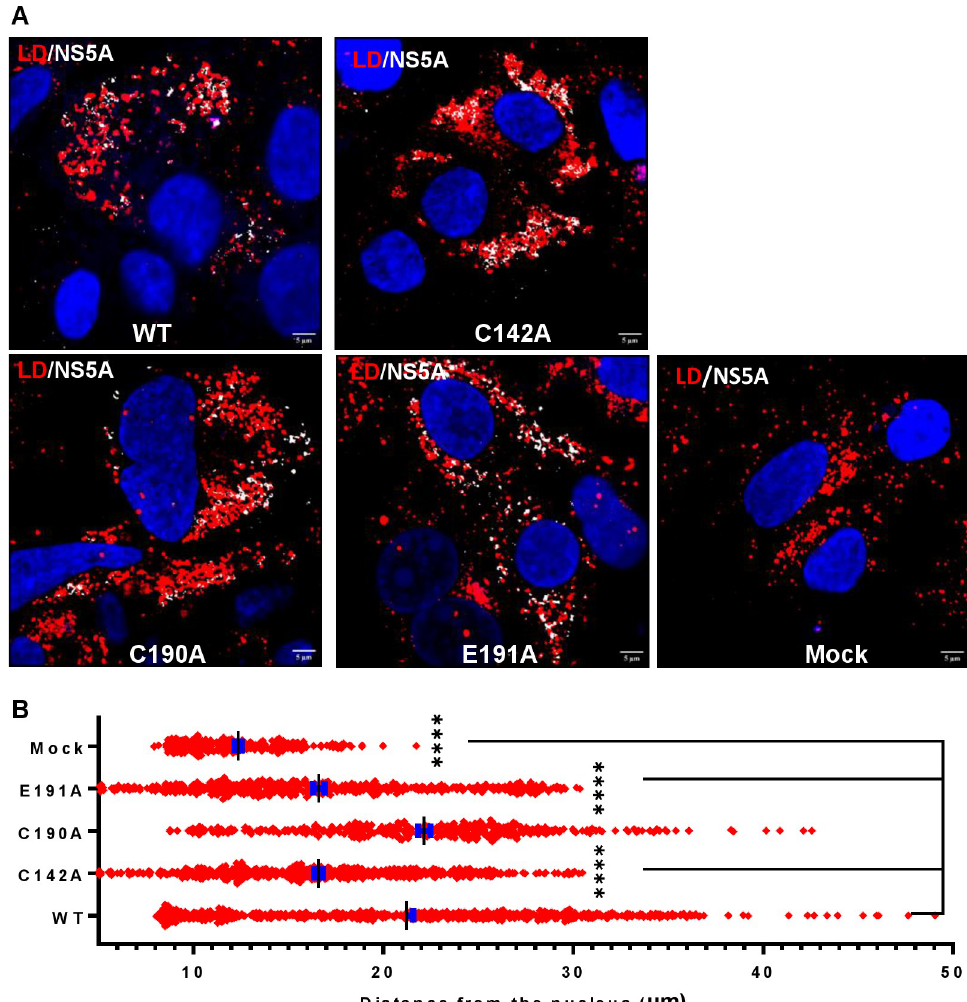
Particles module of Fiji. 10 cells were analysed for each sample. Significant differences from WT denoted by ���� (P <